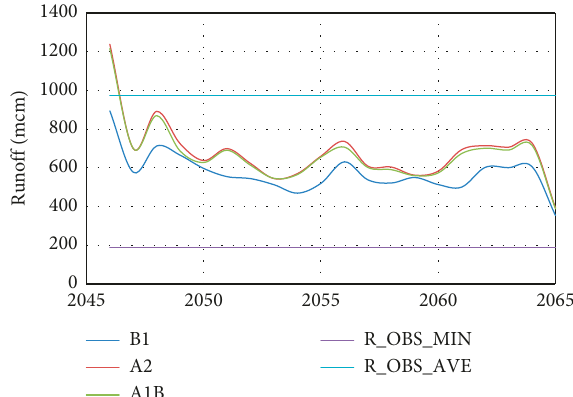
Figure 15: Comparison of the minimum and average observational runoff and the future middle period under the ensemble model and three emission scenarios.